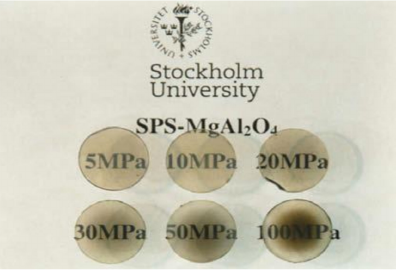
Figure 1. The 12 mm diameter magnesium spinel samples demonstrating sintering inhomogeneities occurring during spark plasma sintering (SPS). Direct observation of the inhomogeneities is possible due to the observed optical di ff erences, accentuated with increasing uniaxial pressure applied during the heating ramp prior to reaching the final dwell temperature (1300 ◦ C for 3 min). The brownish-black discoloration is believed to be directly linked to dislocation stabilized oxygen vacancies, likely to be generated as a result of superplastic deformation occurring at low temperature [47]. (reprinted with permission from